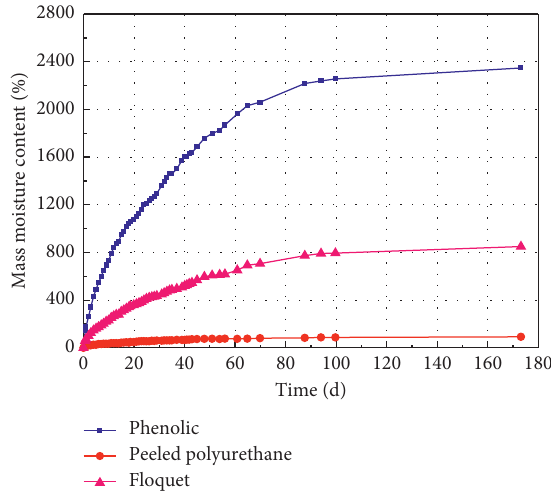
Figure 8: Curve of the water content of the thermal insulation layer material with time after complete